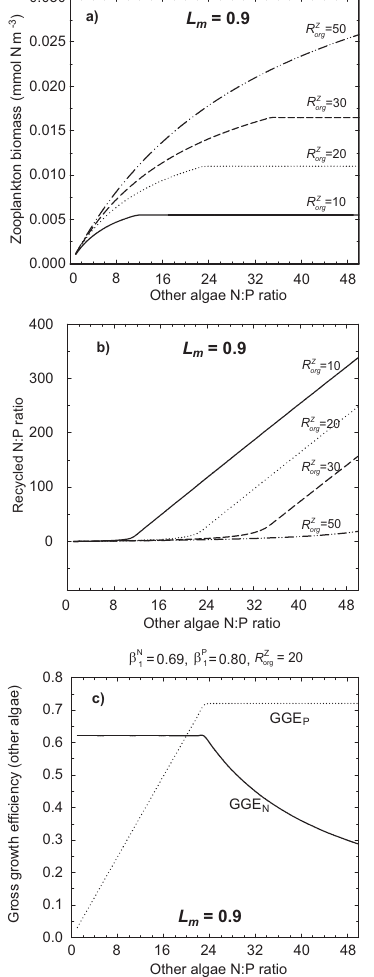
Fig. 4. (a) Global herbivore biomass (mmolNm − 3 ) plotted against the ratio of nitrogen to phosphorus (N:P) in non-fixers, using four different N:P ratios in herbivores; (b) The N:P ratio of the products released by herbivores plotted against the N:P ratio in non-fixers; (c) Gross growth efficiency of N (GGE N ) and P (GGE P ) plotted against the N:P ratio in non-fixers ( R O org ) using the following set = 0 . 69 and β P = 0 . 80, of parameters: assimilation efficiencies, β N 1 1 maximum accumulation efficiency, L m = 0 . 9, and N:P ratio in her- bivores, R Z org